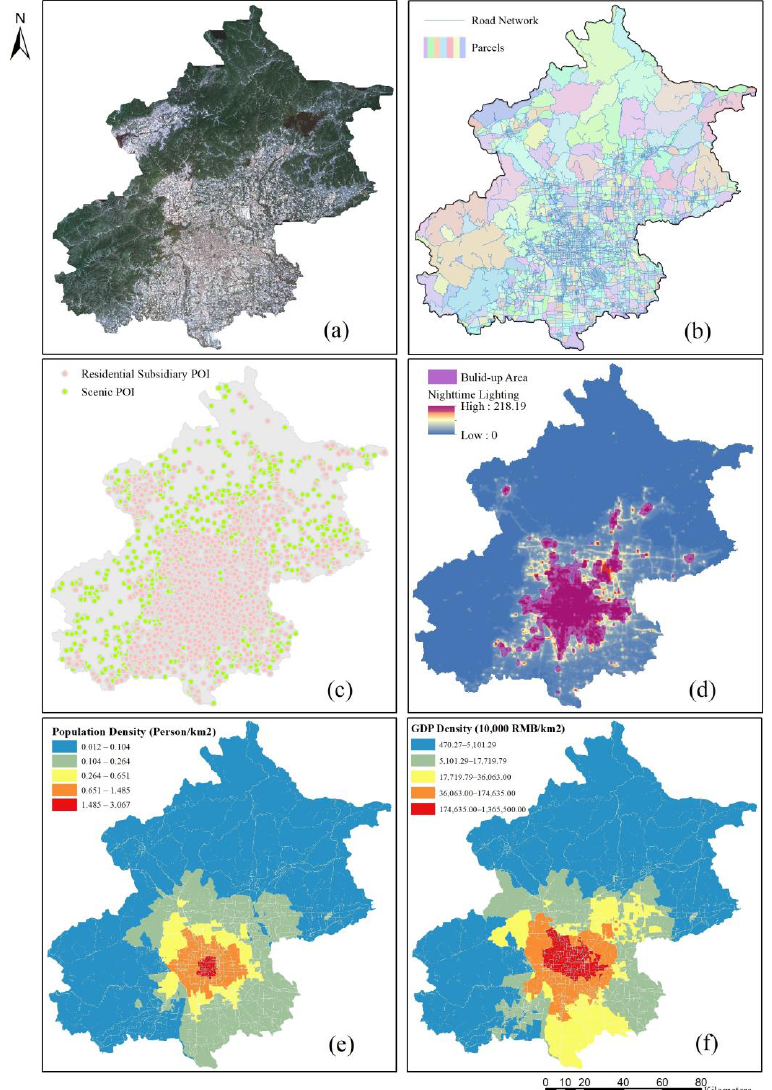
Figure 3. Pre-processed remote sensing image (a), road network and parcels (b), POI distribution (c), nighttime lighting and urban built-up area (d), population density of each parcel (e), GDP density of each parcel (f) in the study area.